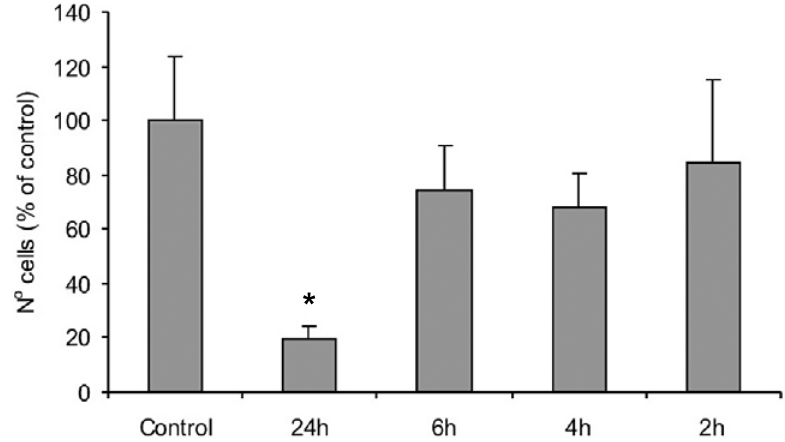
FIGURE 2- Number of cells counted in contact with artificial saliva over 2, 4, 6 and 24 h, expressed as percentage of control. Data are shown as mean and bar indicates standard deviation (n=4). * statistically different from all the other